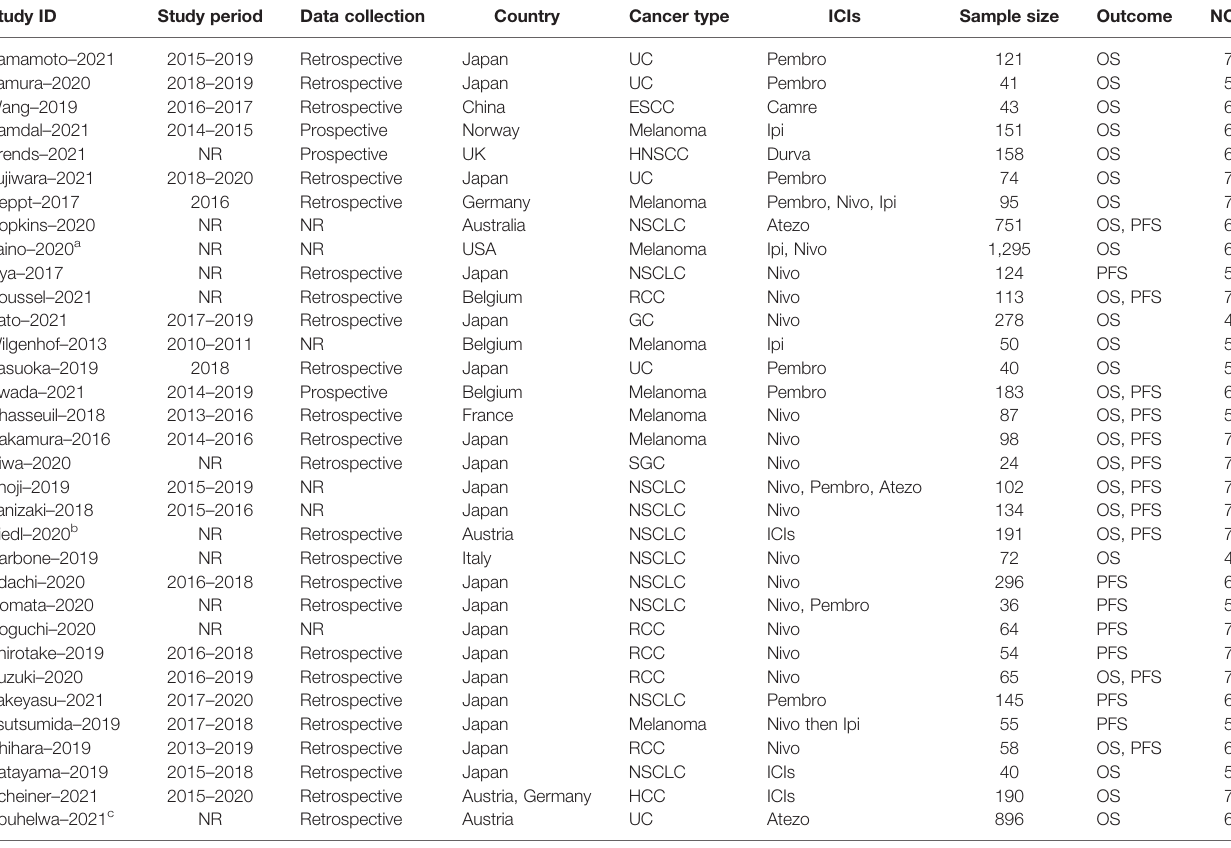
TABLE 1 | Characteristics of the included